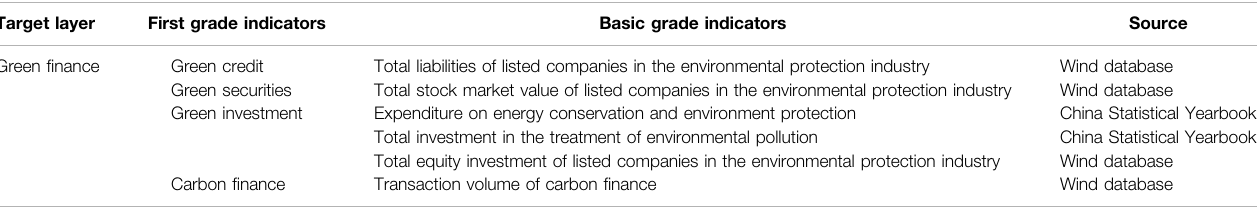
TABLE 1 | The evaluation indicator system for assessing green fi nance.